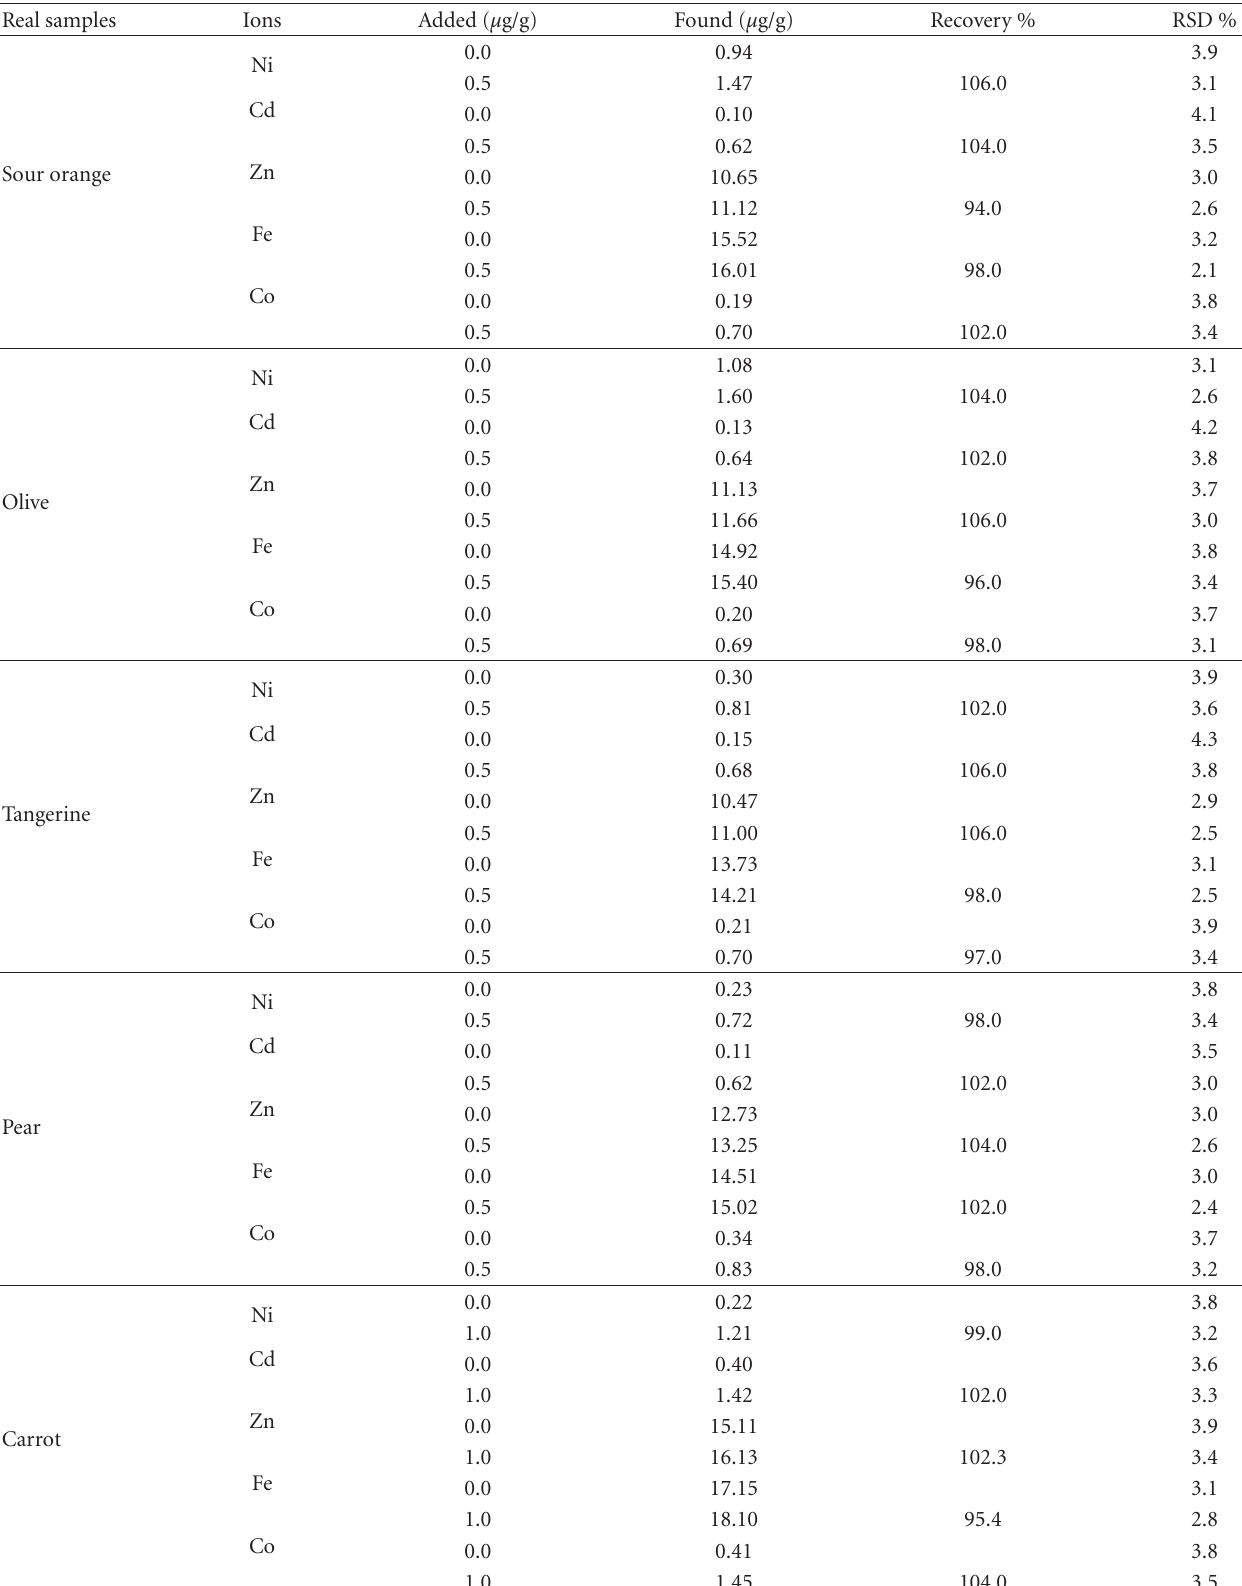
Table 5: Recovery studies of trace metal ions from some real